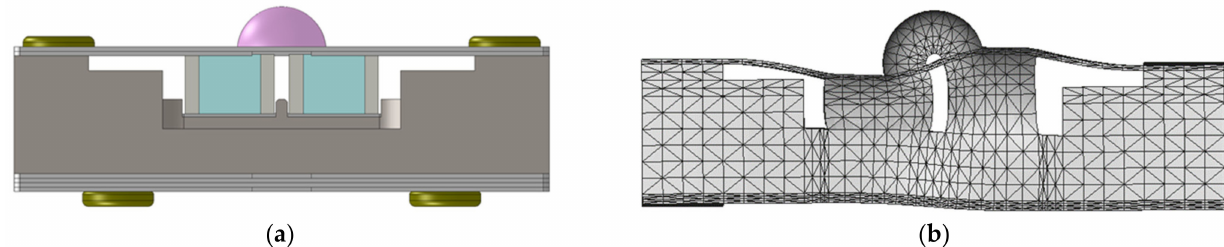
Figure 1. ( a ) Stator of the two-phase piezoelectric inertia-drive-type motor. ( b ) Synchronous deforma- tions of the multilayer actuators in their thickness directions are transferred into a rotary movement of the friction